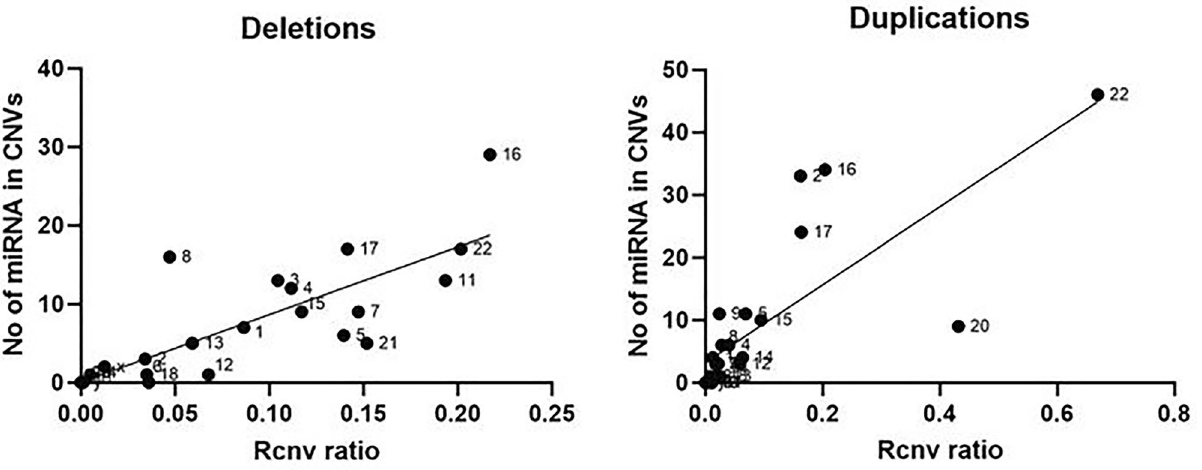
Figure 6. Correlation graph between the number of miRNA genes in rare CNVs and the fractional CNV lengths (Rcnv ratio). For each chromosome, the number of miRNA genes associated with CNVs is plotted as a function of the fractional length of CNV over the chromosome’s size for deletions and duplications, respectively. The graphs depict that most of the data points group close to the best-fit line, indicating a positive correlation between the two variables. However, in certain chromosomes CNVs affect a number of miRNA genes which is higher or lower than expected for the given Rcnv ratio, thus behaving as outliers (correlation analysis was performed on data represented in Table